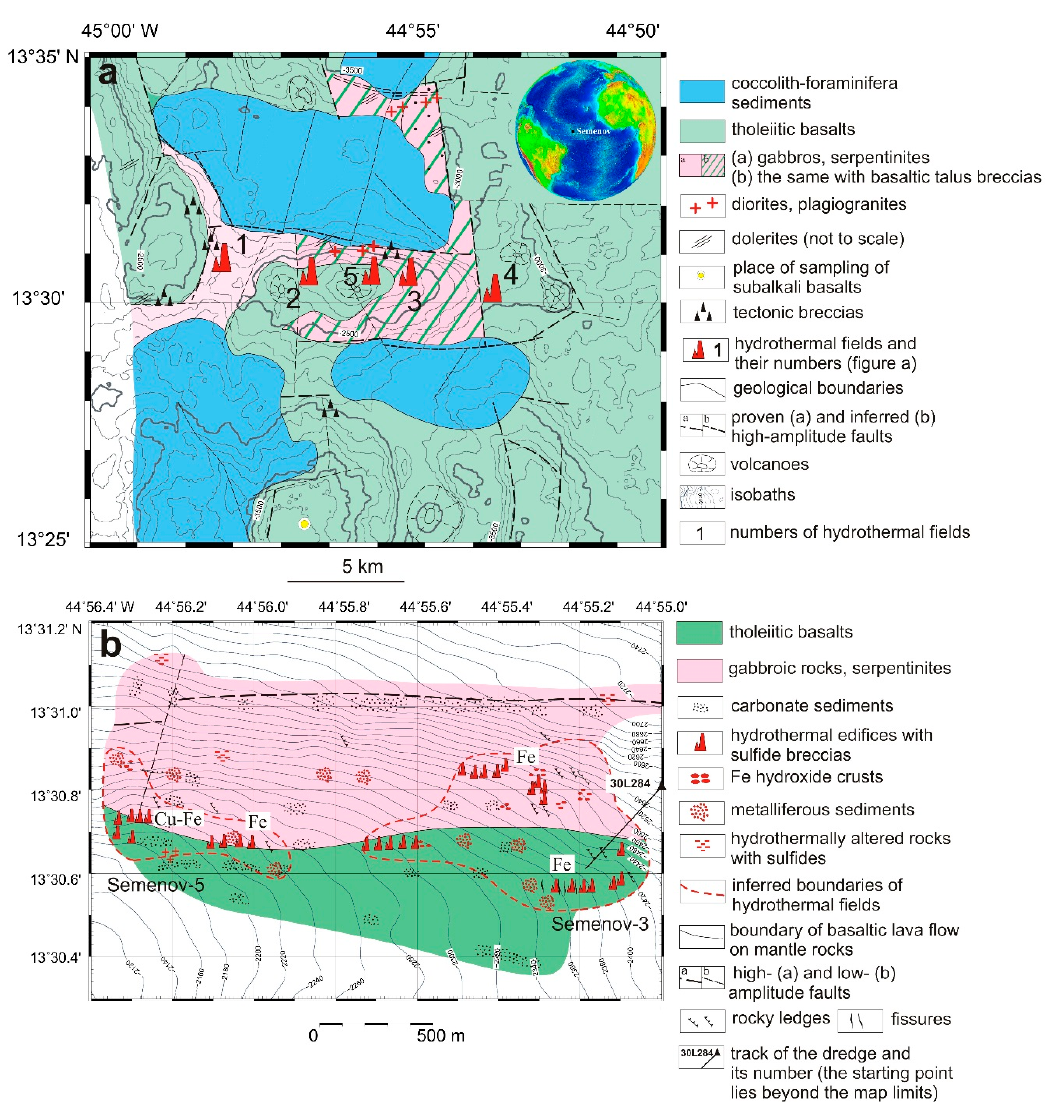
Figure 1. Geological scheme of the Semenov hydrothermal cluster in the Central Atlantic ( a ) and Semenov-3 hydrothermal field ( b ), simplified after unpublished PMGE open-file reports (2007, 2009).